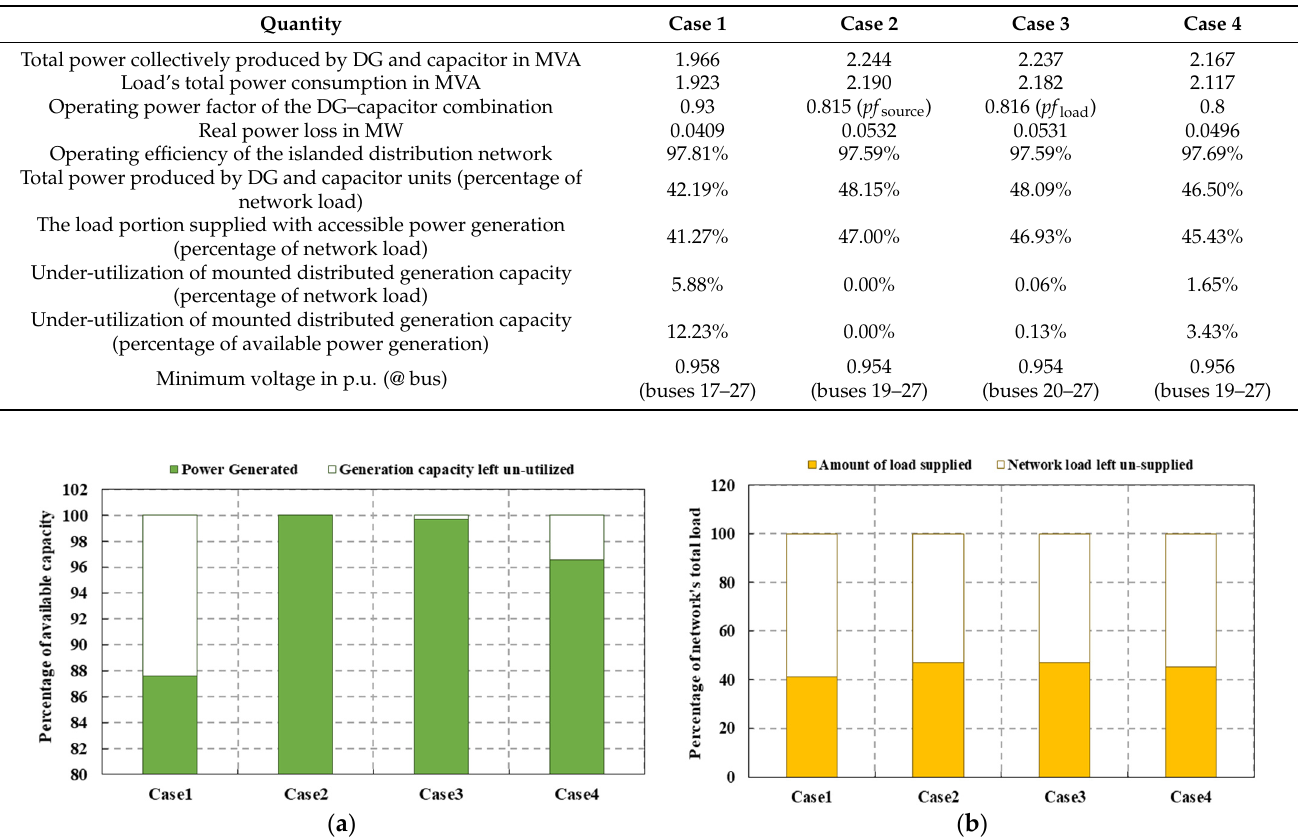
Table 4. Results for the 69-bus autonomous distribution network.